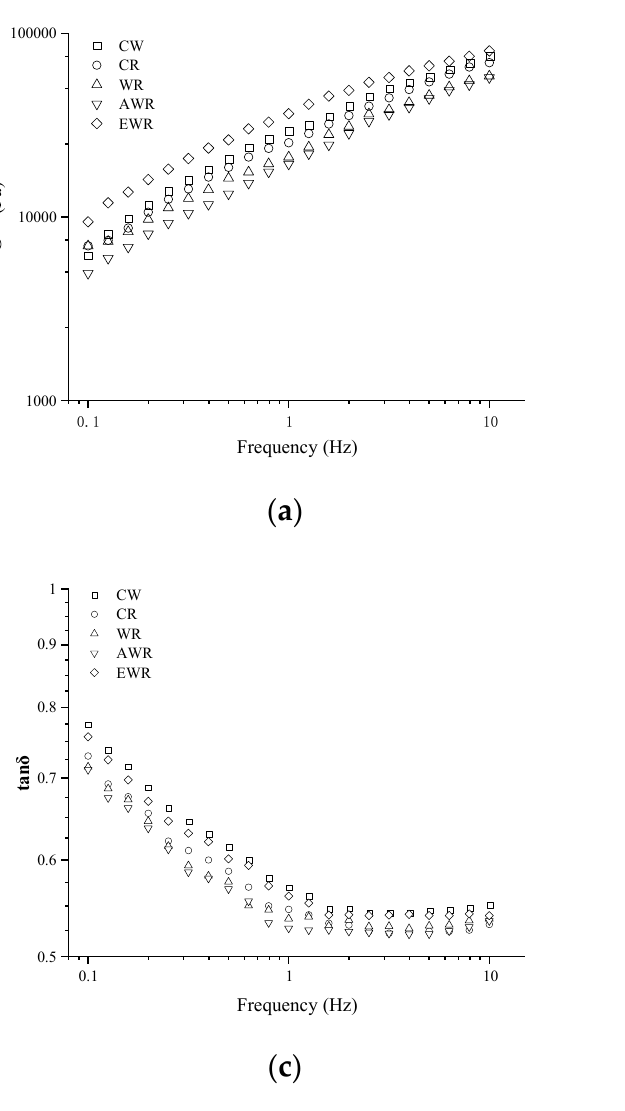
Figure 1. Effect of in situ-formed EPS in sourdough on the rheological properties of dough: ( a ) storage modulus (G ′ ) and ( b ) loss modulus (G ″ ) and ( c ) tan δ of dough.